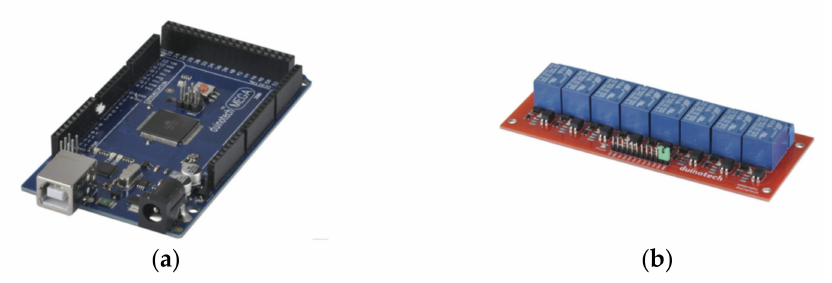
Figure 10. Micro-controller hardware. ( a ) Duinotech MEGA 2560 r3; ( b ) 8 channel relay boards [30].